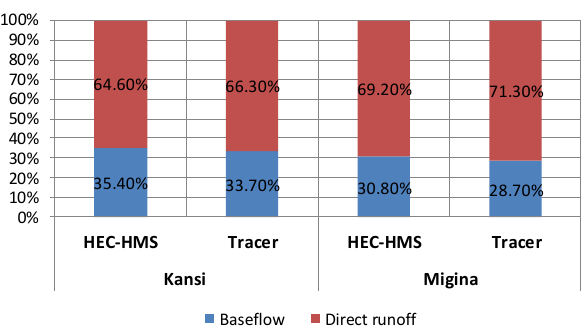
Figure 3 The simulated and observed hydrographs at a) Cyihene-Kansi, b) Migina outlet, c) Munyazi, d) Mukura, and e) Akagera sub-catchments.